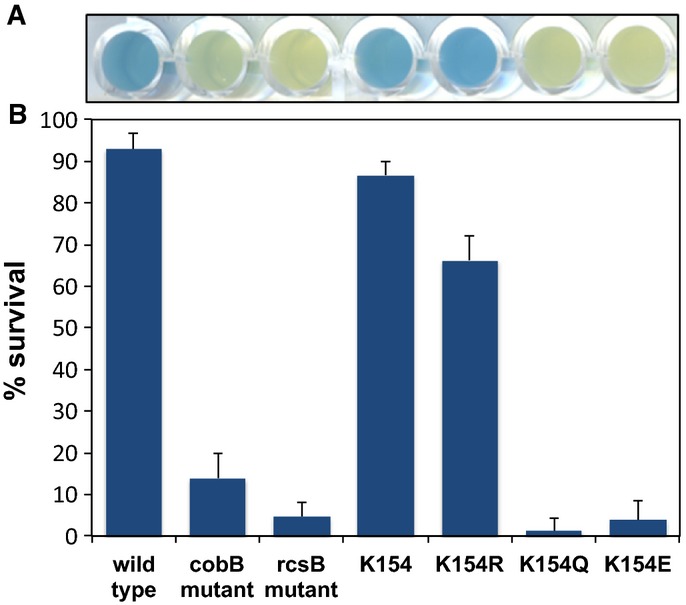
Effect of RcsB inactivation on acid stress responseGlutamate decarboxylase (Gad) enzyme activity. Colorimetric enzyme activity assay was followed by
the consumption of H+ increasing the pH of the reaction in vitro.
The increase of pH was detected by the color turn from yellow to blue of the pH indicator
bromocresol green.Acid stress survival of the different E. coli mutants. The effect of
cobB and rcsB deletion on acid stress survival of E.
coli was analyzed. The rcsB knockout mutant was complemented with the
rcsB wild-type gene (K154) and its different mutants mimicking different acylation
states of lysine 154 (K154R, K154Q and K154E). Bacteria were grown overnight in minimal medium with
pH 5.5 to pre-adapt them to growth at low pH. These bacteria were subjected to acid stress for 2 h
(pH 2.5), and cell survival was measured afterward. Mean values ± SD are shown
(n = 3).Source data are available online for this figure.